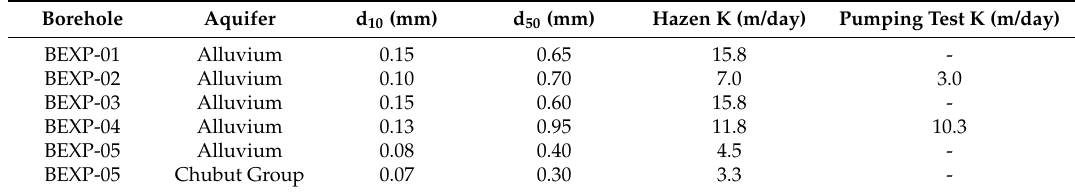
Table 1. Sediment parameters and hydraulic conductivity estimations.